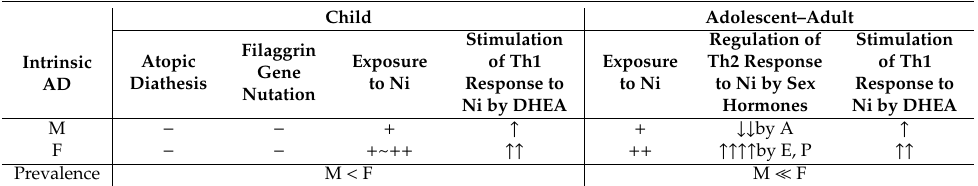
Table 7. Female preponderance of intrinsic atopic dermatitis